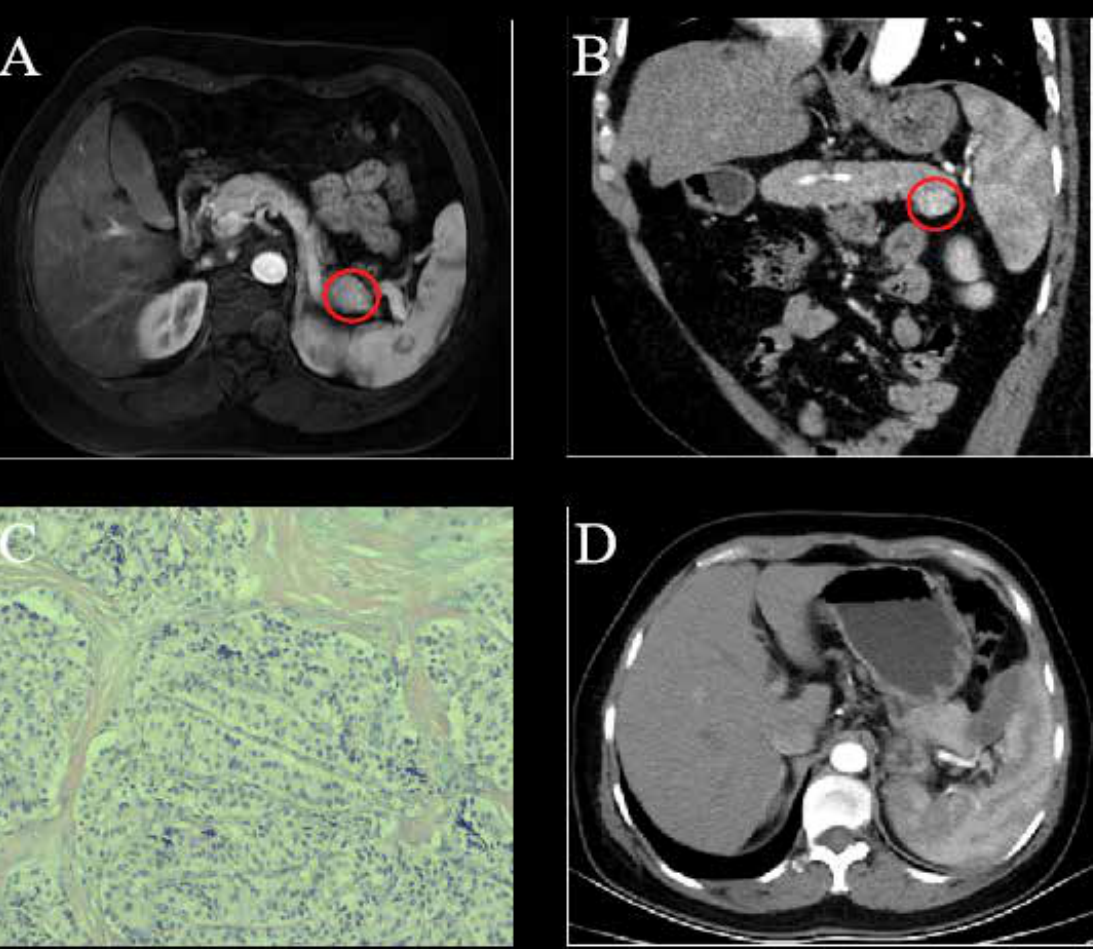
Figure 1: A 44-year-old female with pathology-proven pancreatic insulinoma was treated with laparoscopic RFA. (A) Contrast-enhanced MRI showed a round-like, well-defined lesion in the pancreatic tail in the arterial phase (red cycle). (B) Coronal reconstructed CT image showed the tumor grew in an exophytic pattern (red cycle). (C) Pathology confirmed the diagnosis of pancreatic insulinoma (HE×100). (D) Con- trast-enhanced CT showed no residual tumor foci and recurrent lesion with a small volume of fluid collection near the pancreatic